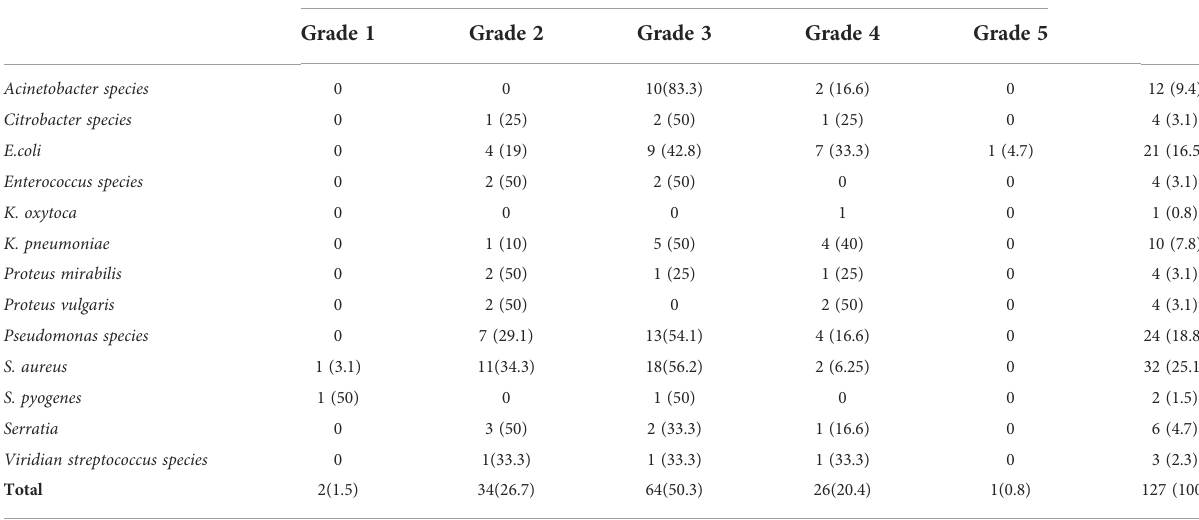
TABLE 3 Distribution of bacterial isolates among Wagner classi fi cation of DFUs system. Isolated Bacteria